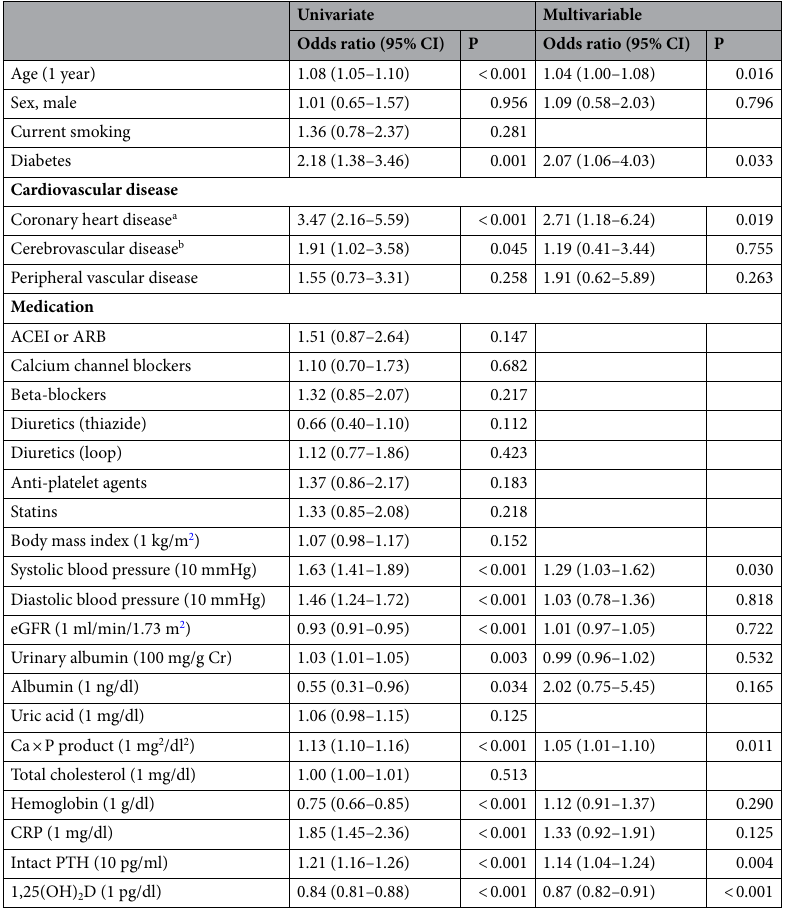
Table 2. Univariate and multivariable analyses for variables associated with aortic valve calcification in the study population (n = 513). Data are presented as odds ratio and 95% confidence interval (CI). a Coronary heart disease is defined as a history of coronary artery bypass surgery or percutaneous transluminal coronary angioplasty. b Cerebrovascular disease is defined as a history of stroke or transient ischemic attack. ACEI angiotensin-converting enzyme inhibitors, ARB angiotensin receptor blockers, Ca × P product, calcium × phosphorus product, CKD chronic kidney disease, CRP C-reactive protein, eGFR estimated glomerular filtration rate, PTH parathyroid hormone, 1,25(OH) 2 D 1,25-dihydroxyvitamin